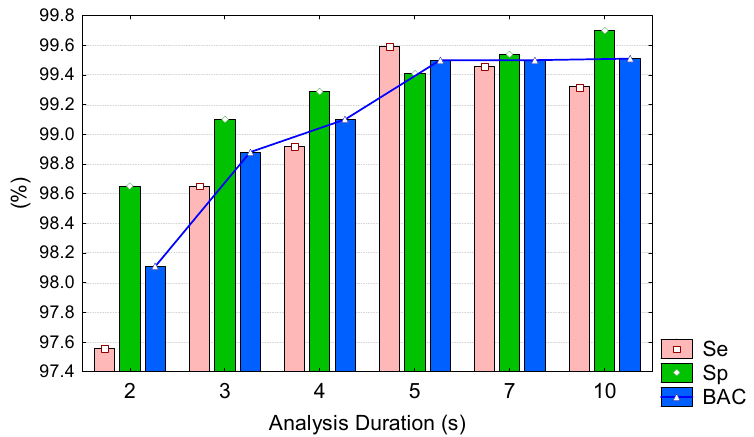
Figure 10. Validation sensitivity (Se), specificity (Sp), and BAC of our best CNN model ( HPbest ) for different analysis durations of the input ECG signal. Table 4. Performance of our best CNN model with 2–10 s analysis durations, reported for all rhythms in different validation databases.